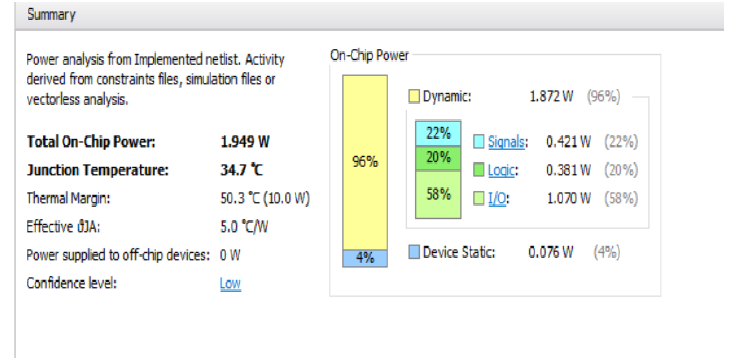
Figure 10. Trojan-free summary